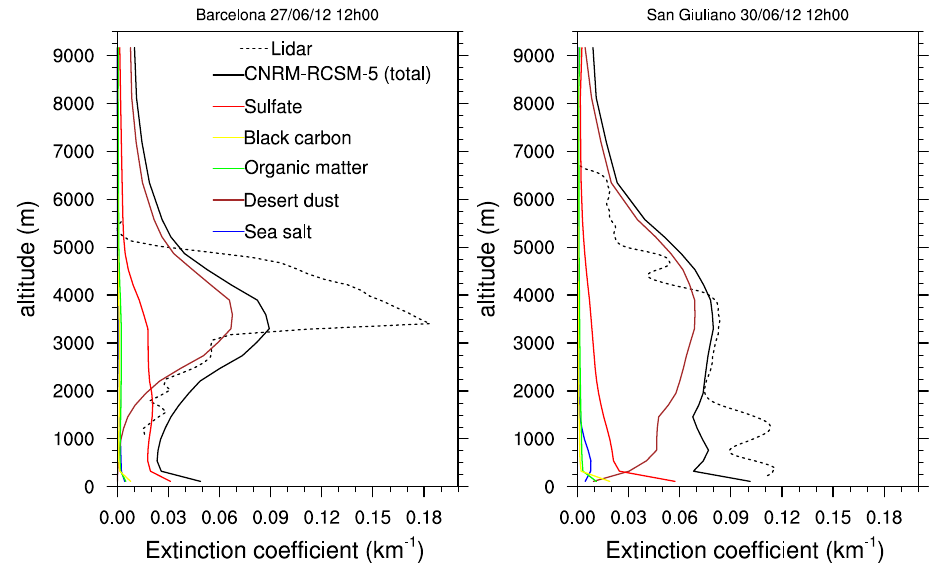
Figure 6. Aerosol extinction coefficient simulated by CNRM-RCSM5 (full black lines) and observed by a ground-based lidar (dotted black lines) in Barcelona on 27 June at 12:00UTC (left) and in San Giuliano (Corsica) on 30 June 2012 at 12:00UTC (right). The different coloured lines represent the contribution of each aerosol type to the extinction coefficient.